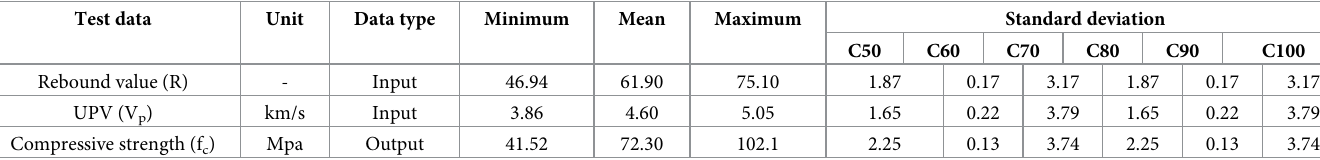
Table 8. Statistics of the test datasets.